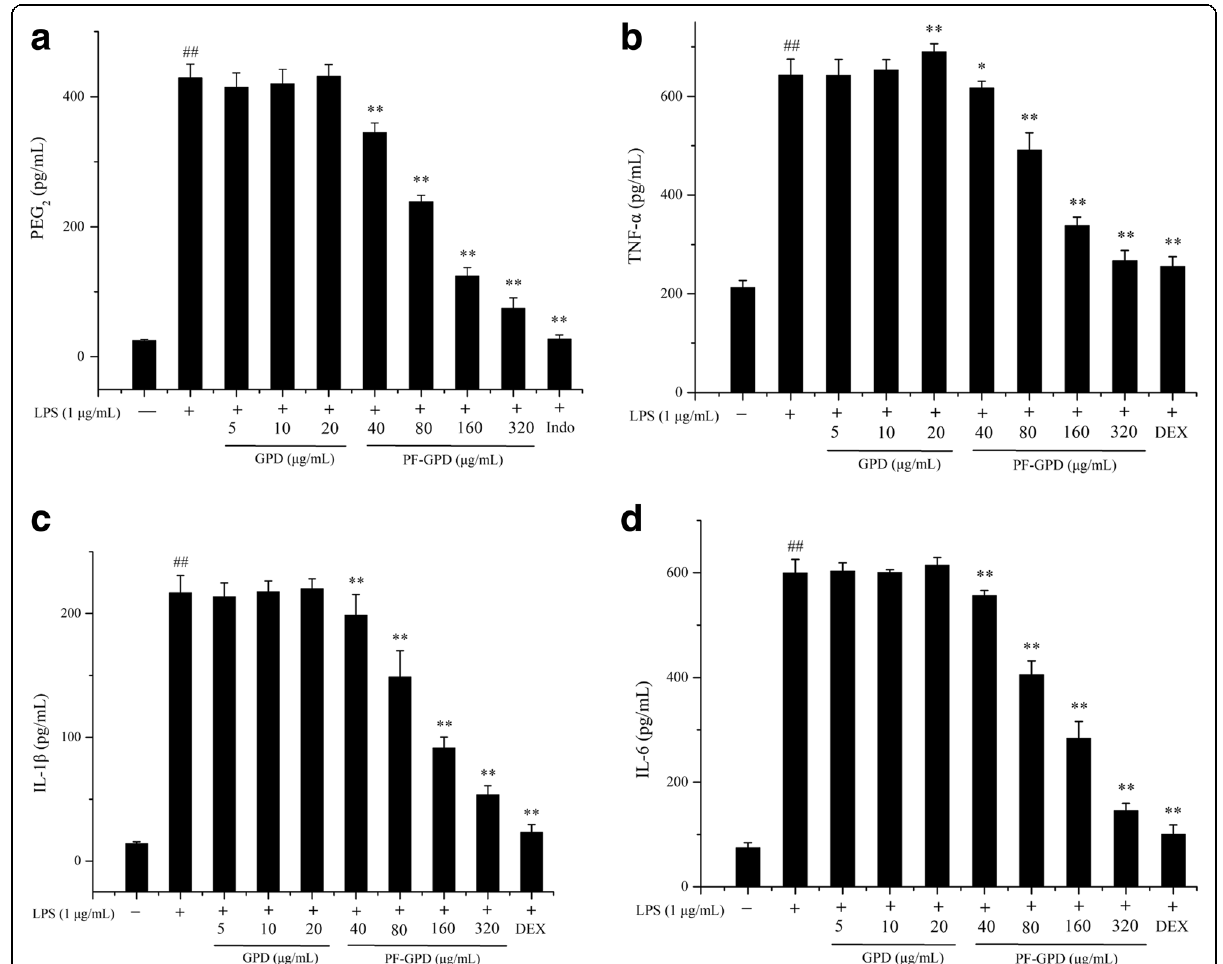
Fig. 4 Effect of PF-GPD on LPS-stimulated iNOS ( a ) and COX-2 ( b ) expression in RAW 264.7 cells. Cells pretreated with indicated concentrations of PF-GPD for 6 h were stimulated without or with 1 μ g/mL of LPS for 24 h. The expressions of iNOS, COX-2 and β -actin proteins were detected by Western Blot using corresponding antibodies. ## P < 0.01 compared with untreated group; * P < 0.05, ** P < 0.01 compared with the LPS